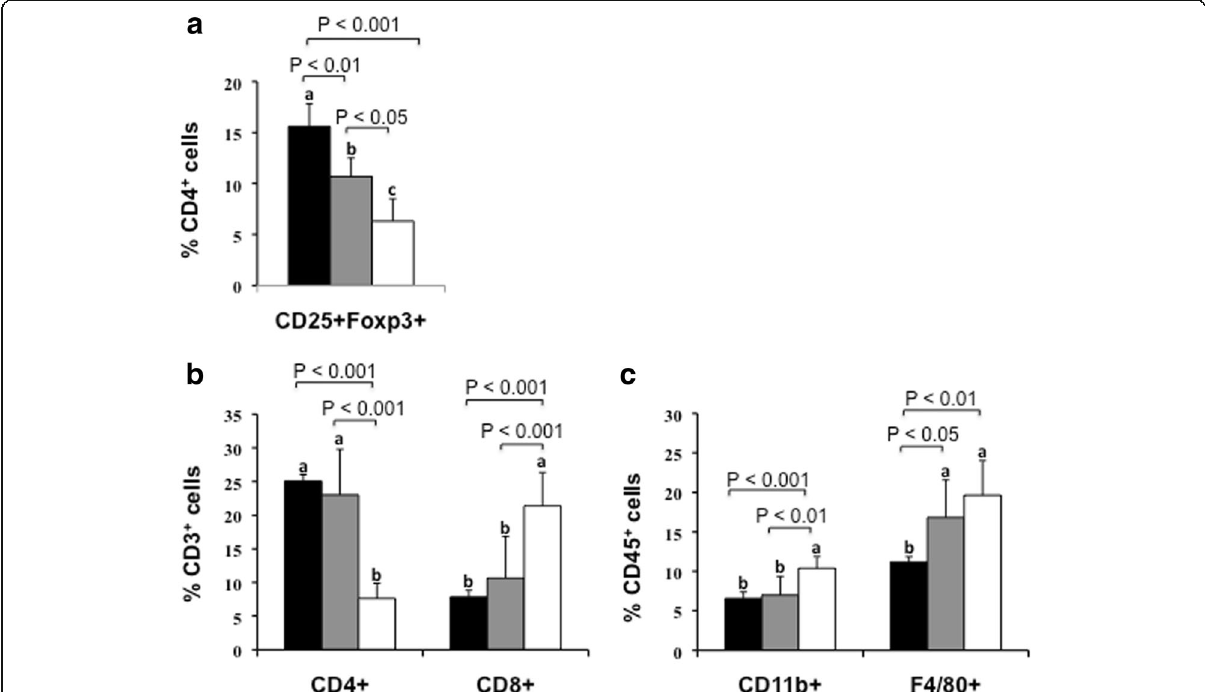
Fig. 2 Leukocyte subpopulations in epididymal WAT. The effect of bacterial supplementation on the frequency of WAT leukocyte subpopulations was analysed by flow cytometry. The percentage of CD25 + Foxp3 + Treg cells was calculated on T lymphocyte gate (CD4+, a ), CD4 + and CD8 + cell subsets were calculated on lymphocyte gate (CD3 + , b ), whereas CD11b + and F4/80 + cells were calculated on leukocyte gate (CD45 + , c ). Black columns: MBC-supplemented mice; grey columns: LGG-supplemented; white columns: CTRL. Each column represents the mean ± SD of nine mice. Means without a common letter significantly